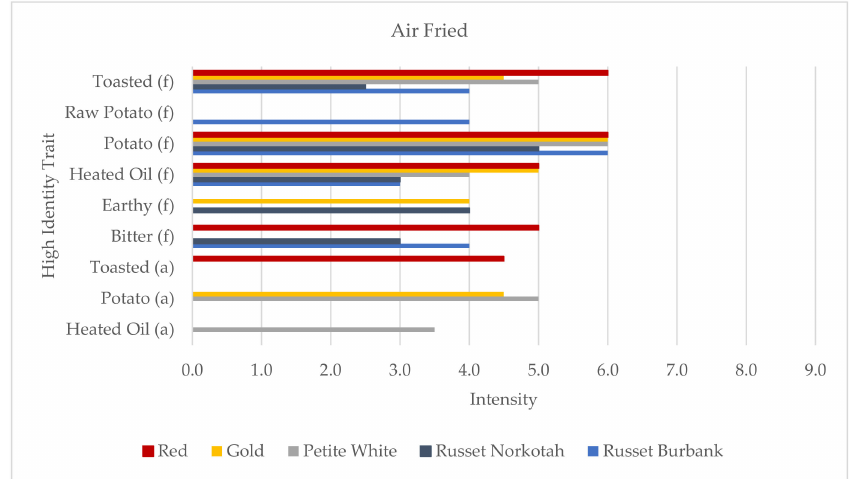
Figure 5. High identity traits (HITs) profiles of the air fried potato samples (aroma (a) the “smell” of the product; flavor (f), tastes, aromatics, and feeling factors while food is being eaten by the mouth; and texture (t)). Intensity was rated on a 0–15 scale with 0.5